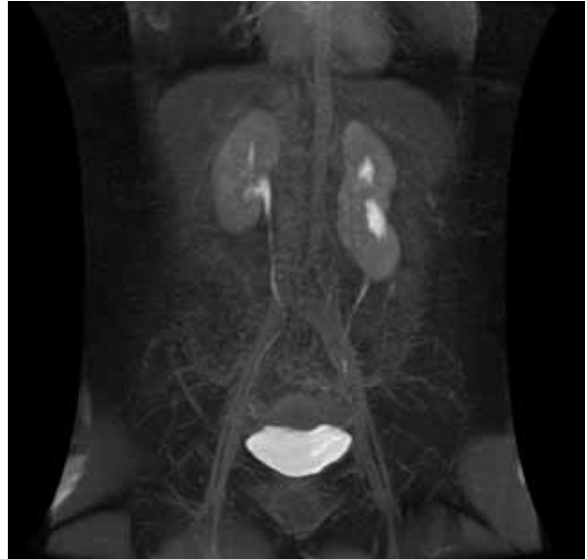
figure 1 - Magnetic ressonance image of abdomen and pelvis of a coronal reconstruction frame in T2. It is possible to observe the fusion of the lower pole of left kidney to the superior pole of the supernumerary